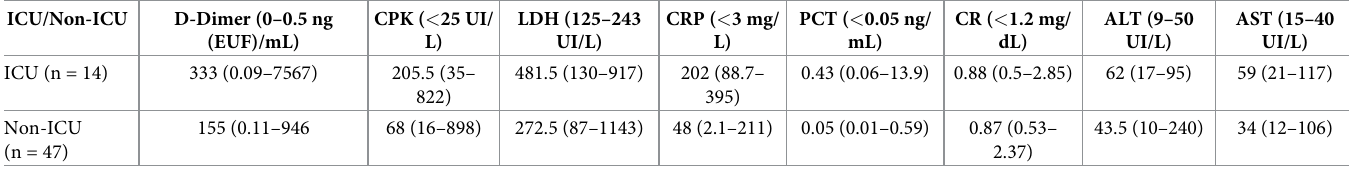
Data collected from 10 to 28 March 2020. Normal ranges of each laboratory parameter are shown in parenthesis in the headers of each column. Values of each cell represent medians. Ranges are depicted in parenthesis. AST = Aspartate transaminase.